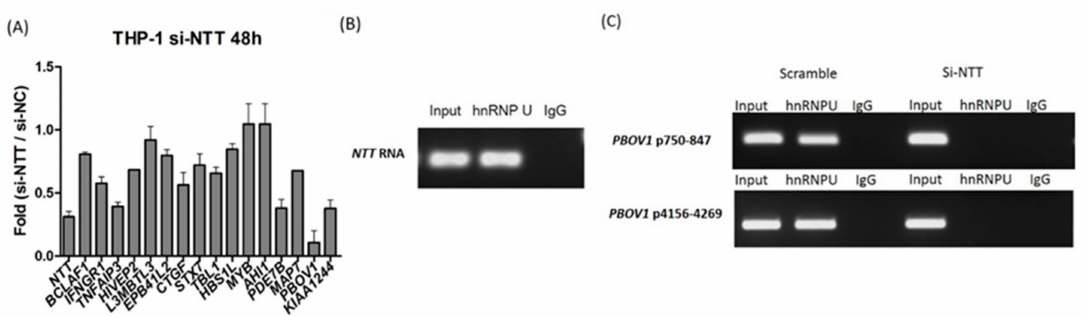
Figure 2. NTT acts in cis on genes at the local proximity. ( A ) Knockdown of NTT in THP-1 cells resulted in decreased expression levels of downstream genes, with the most prominent effect on PBOV1 ; n = 3, bars represent mean ± SEM. ( B , C ) NTT regulates PBOV1 via binding with hnRNP-U to the PBOV1 promoter. ( B ) NTT RNA binds to hnRNP-U as detected by RNA IP; representative graph from three independent experiments. ( C ) DNA ChIP assay detecting the promoter sequence of PBOV1 (2 positions) using anti-hnRNP U antibody in THP-1 cells transfected with si-RNA for NTT or scramble control; representative graph from three independent